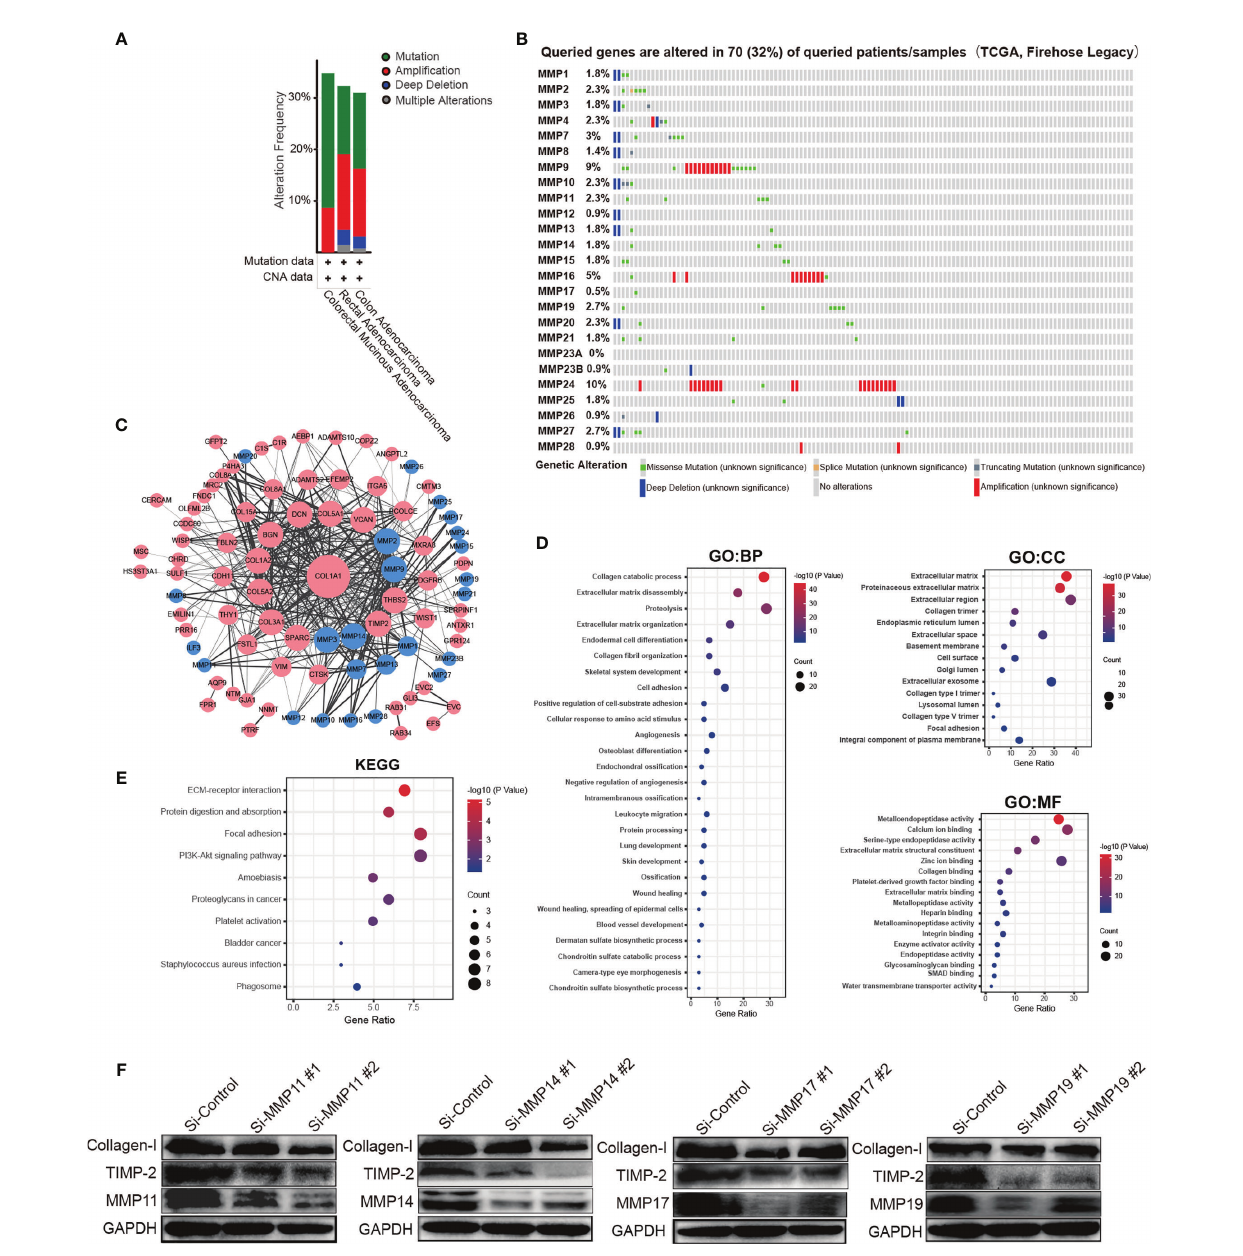
FIGURE 6 | Prediction function and pathways of the changes in MMPs and their frequently altered neighbor genes in patients with colorectal cancer. (A) Overview of mutation and copy number validation of MMPs in different types of colorectal cancer, (B) detailed alteration proportion and types of each MMP gene, (C) network analyses for MMPs and their 50 most frequently altered neighbor genes. (D) GO pathway analyses for MMPs and the genes signi fi cantly associated with MMP alterations. (E) KEGG pathway analyses for MMPs and the genes signi fi cantly associated with MMP alterations. (F) the expression levels of collagen-I (COL1A1) and TIMP2 after knocking down of MMP11, MMP14, MMP17, and MMP19 in HCT116 cell line by using